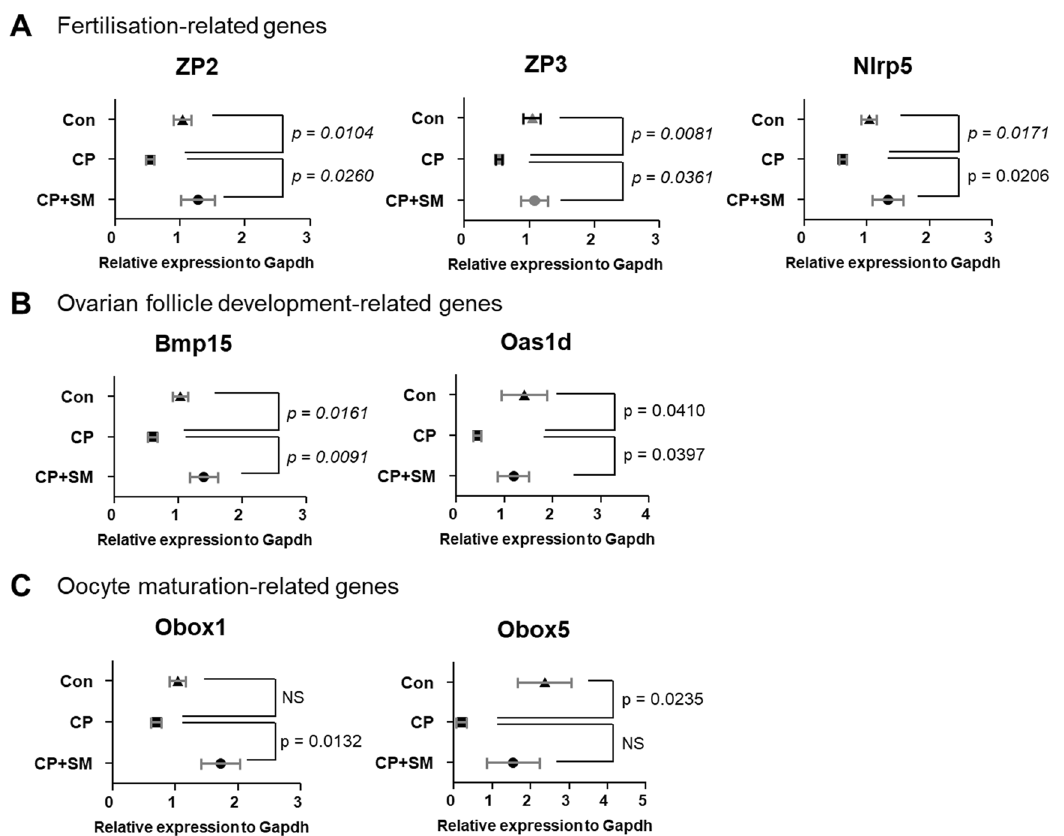
Figure 6. Validation of the expression of differentially expressed mRNAs involved in ovarian function. qPCR was performed to validate the expression of ( A ) Zp2 , Zp3 , and Nlrp5 genes involved in fertilisation, ( B ) Bmp15 and Oas1d genes, involved in ovarian follicle development, and( C ) Obox1 and Obox5 genes, involved in oocyte maturation, in the ovaries of the Con, CP, and CP + SM mice. Statistical analysis was performed using the Student’s t -test. Con: saline-treated control mice; CP cyclophosphamide-treated mice; CP + SM CP-treated mice orally administered